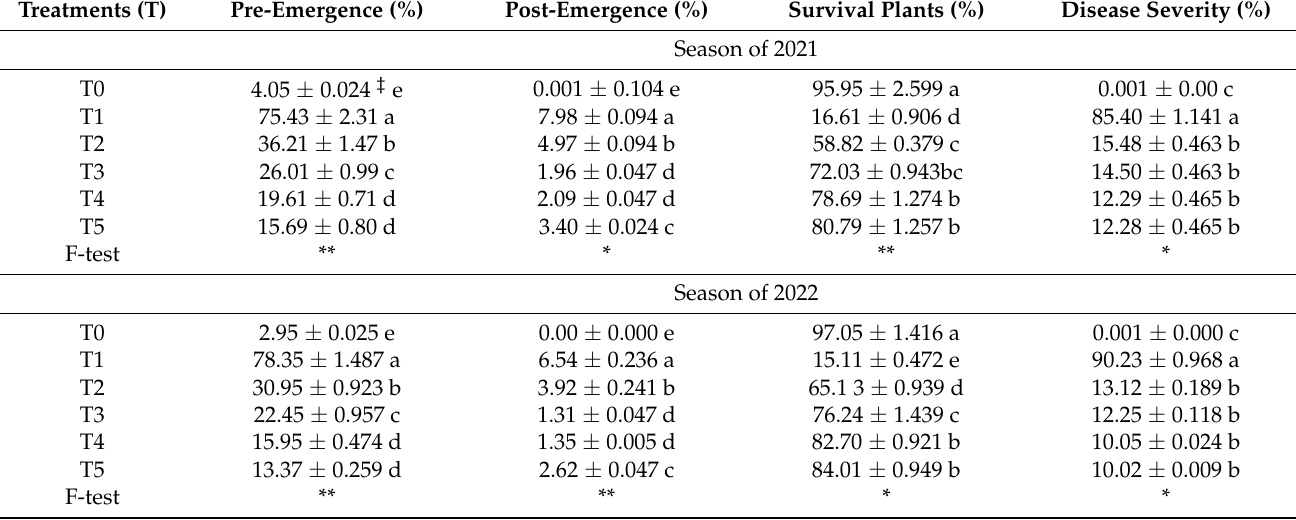
Table 6. Effect of treatments on pre-, and post-emergence, survival plants and disease severity percent of tomato seedlings that infected with R. solani compared to control or healthy